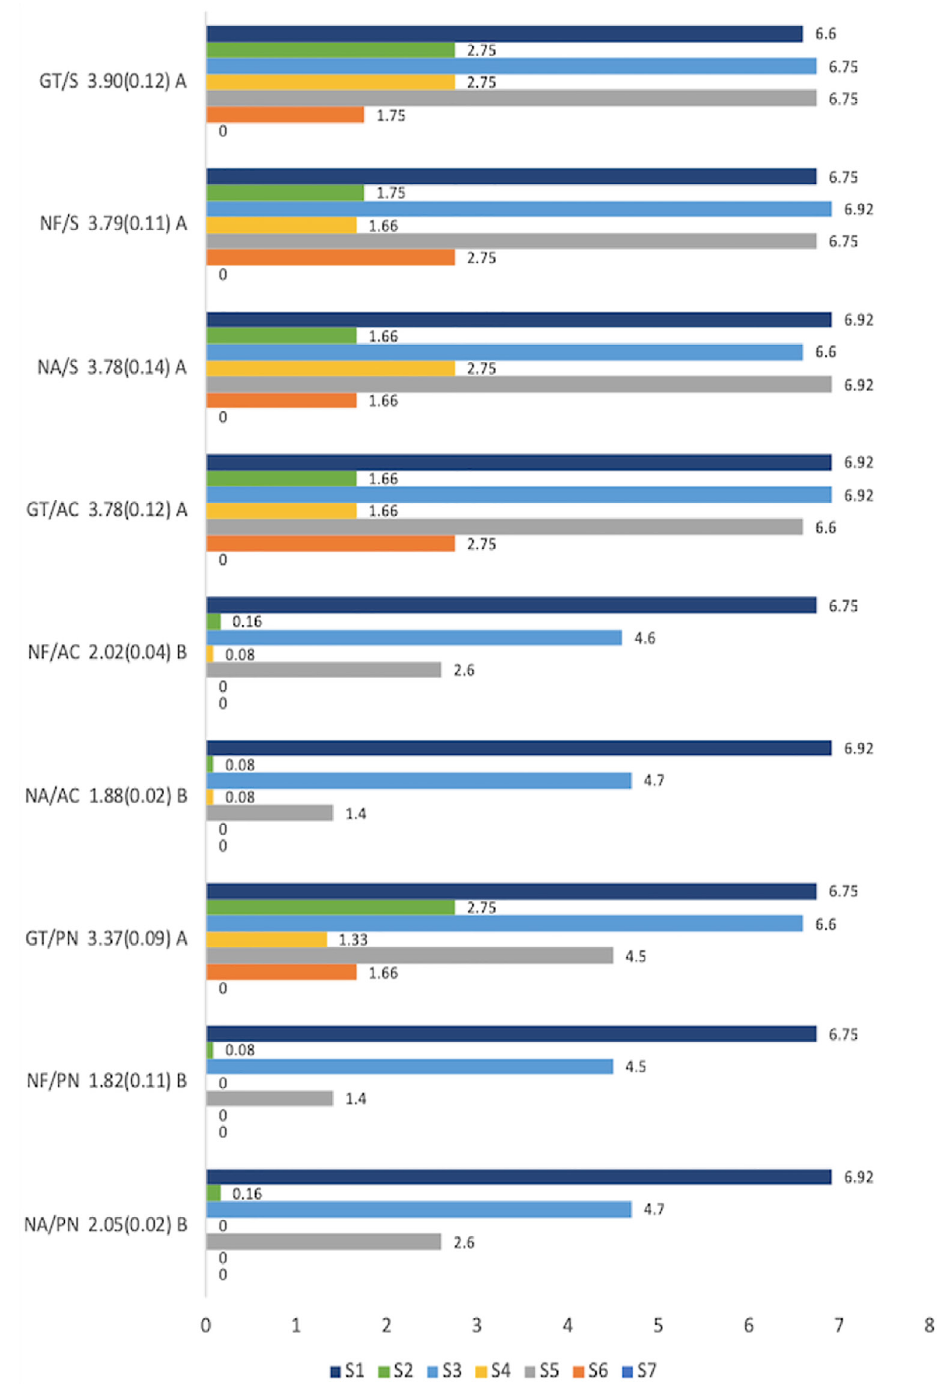
Figure 5- Mean, standard deviation, and Lambda Wilks test for pain sensitivity during the bleaching